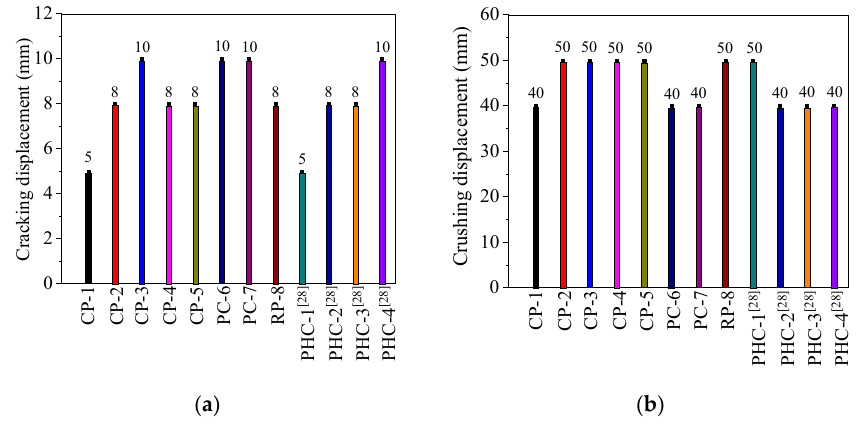
Figure 14. Cracking and crushing displacements of the concrete specimens. ( a ) Cracking displacement. ( b ) Crushing displacement. ( b ) Crushing